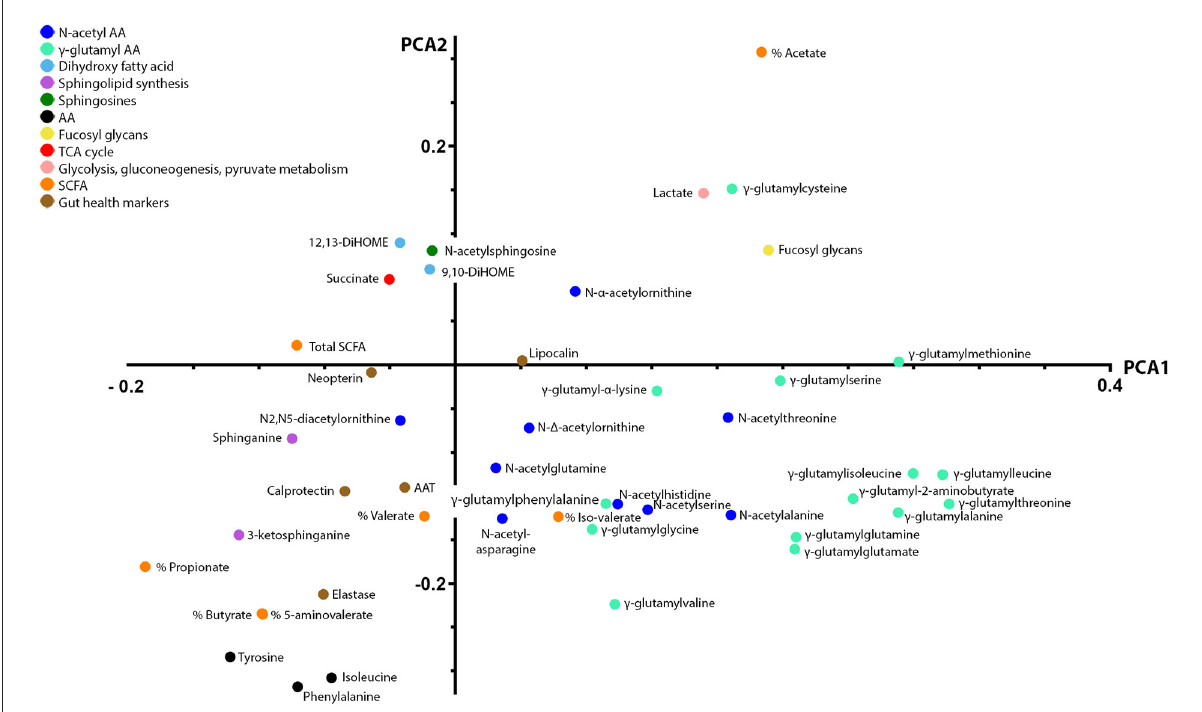
FIGURE3 Principal component analysis loading plot displaying co-variations between 1 H NMR and LC-MS stool metabolites and gut health markers. Principal component analysis was employed to model the main source of variances in the dataset and describe variable co-variations. The first two principal components accounted for 18 and 11% of the total variance in the combined data. In the principal component loading plot, each coordinate represents a single metabolite and describes each variable weight in a principal component. The coordinates of each variable are also providing information on how they correlate with one another. Along the first principal component, a positive association between the concentrations in stool calprotectin and elastase and the stool metabolites sphinganine, 3-keto-sphinganine, 5-aminovalerate, butyrate, and propionate was found. In addition, stool calprotectin and elastase showed a negative association with the stool metabolites acetate, lactate, fucosyl-glycans, and most gamma-glutamylated amino